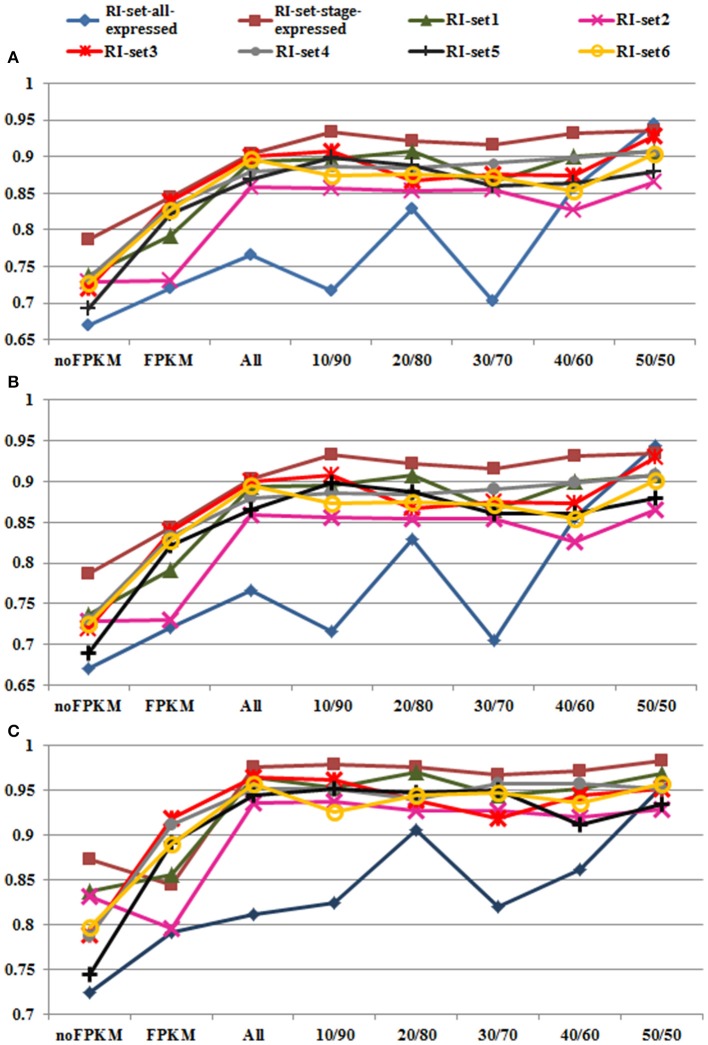
Performances of Random Forest in all datasets. Eight datasets (i.e., the green line with triangle marks for RI-set1, the pink line with  marks for RI-set2, the red line with  marks for RI-set3, the light gray line with filled circle marks for RI-set4, the black line with cross marks for RI-set5, the yellow line with hollow circle marks for RI-set6, the blue line with rhombus marks for RI-set-all-expressed, and the red brown with square marks for RI-set-stage-expressed) respectively represent the RIs and the corresponding CSIs extracted from Sample1, Sample2, Sample3, Sample4, Sample5, Sample6, all expressed in six datasets (RI-set-all-expressed) and co-occurred in the developmental tissues or under stress conditions (RI-set-stage-expressed). For each dataset, nofpkm (classification features except FPKM), fpkm (only FPKM feature) and various subsets of RIs (all classification features) depending on different criteria of expressional retention odds (all, 10/90, 20/80, 30/70, 40/60, and 50/50, Table S2) are prepared to do classification by Random Forest. (A) Depict the obtained performances of accuracy. (B) Describe the obtained performances of F-Measure. (C) Show the obtained performances of AUC. Obviously, 50:50 expressional odds of retention consistently reach the best overall performance (0.909 Accuracy and F-Measure, 0.954 AUC averagely) in all eight experimental datasets.